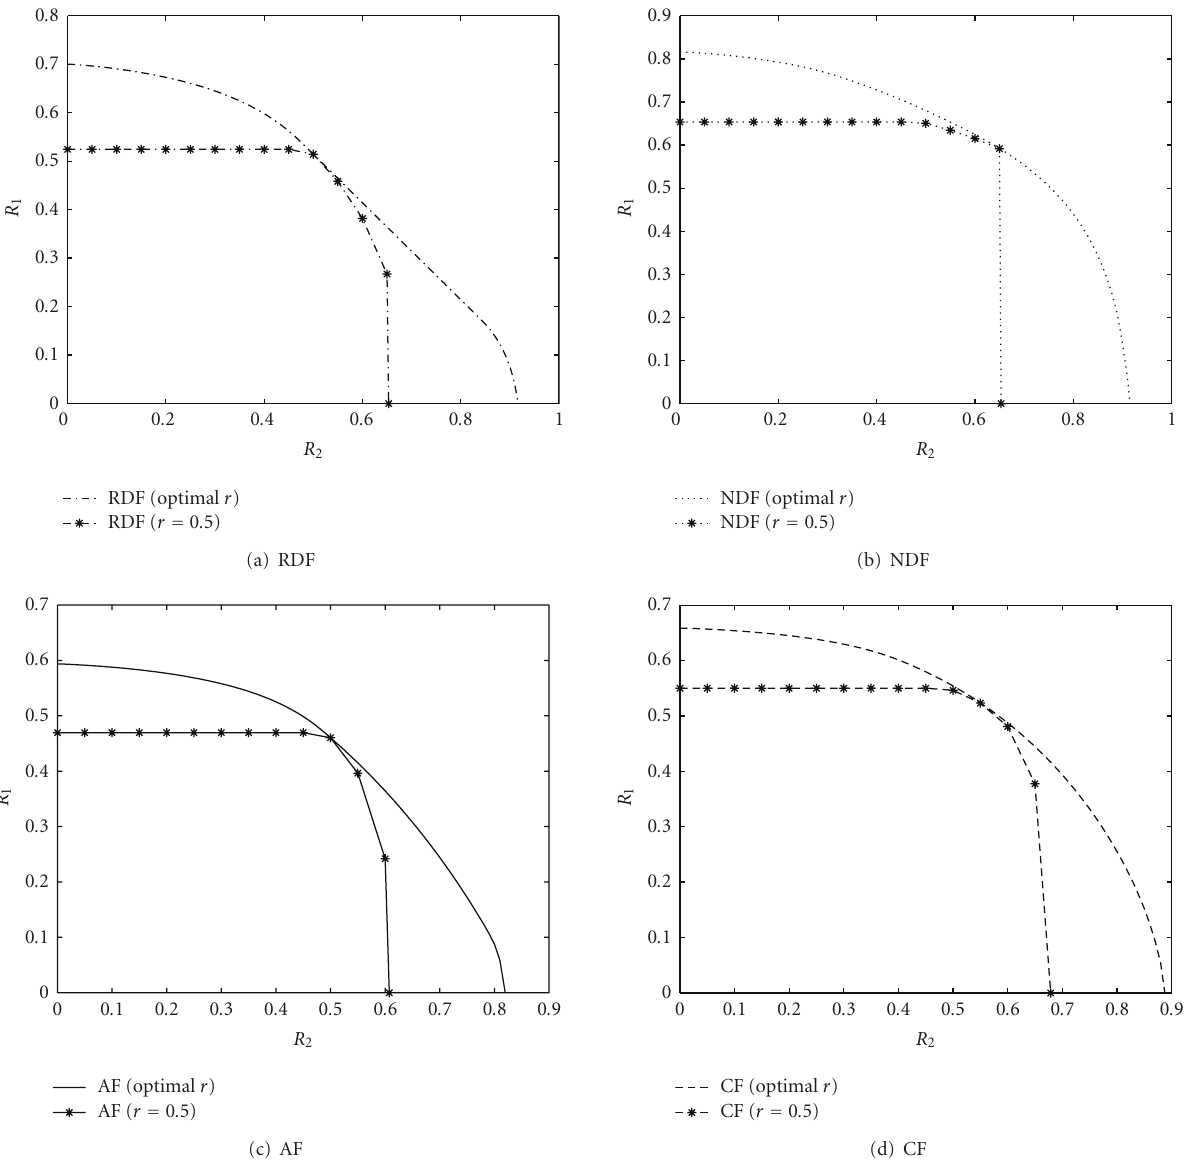
Figure 10: Comparisons between the achievable rate regions obtained by jointly optimal power and resource allocation and those obtained by power allocation only with equal resource allocation, for Scenario